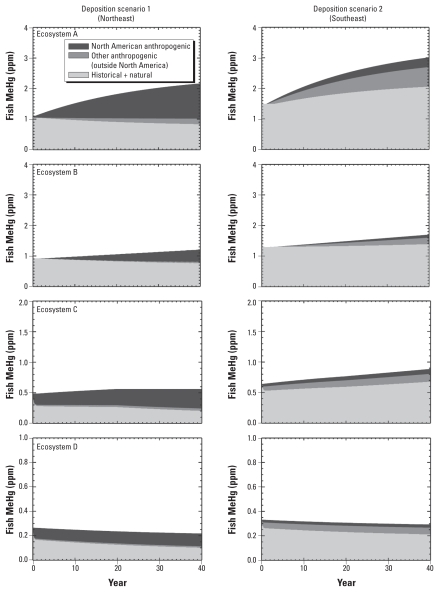
Temporal evolution of fish MeHg sources for model ecosystems A–D to U.S. deposition scenario 1 (Northeast) and scenario 2 (Southeast; see Table 1). Note difference in scale for ecosystems C and D. The model is run for 50 years; the first 10 years are treated as initialization.